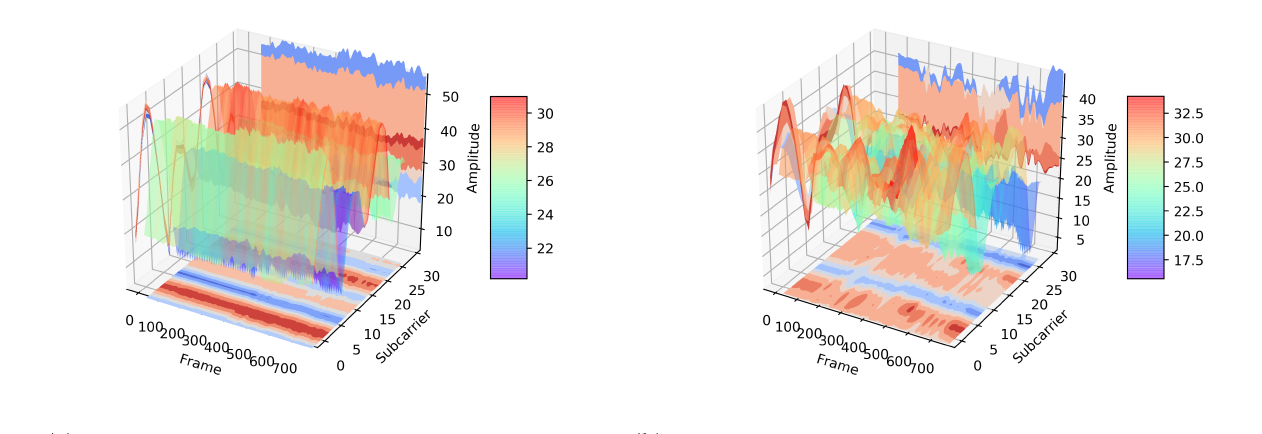
( a ) Three-dimensional map of signal in empty environment. Figure 6. Three-dimensional map of the signal in empty environment and activity-influenced environment. ( a ) Three- dimensional map of signal in empty environment. ( b ) Three-dimensional map of signal in activity-influenced environment. The three coordinate axes are frame-axis, subcarrier-axis, and amplitude-axis, respectively. The three-dimensional waveform can be mapped to three planes, including the planes parallel to the subcarrier-axis and frame-axis, and perpendicular to the